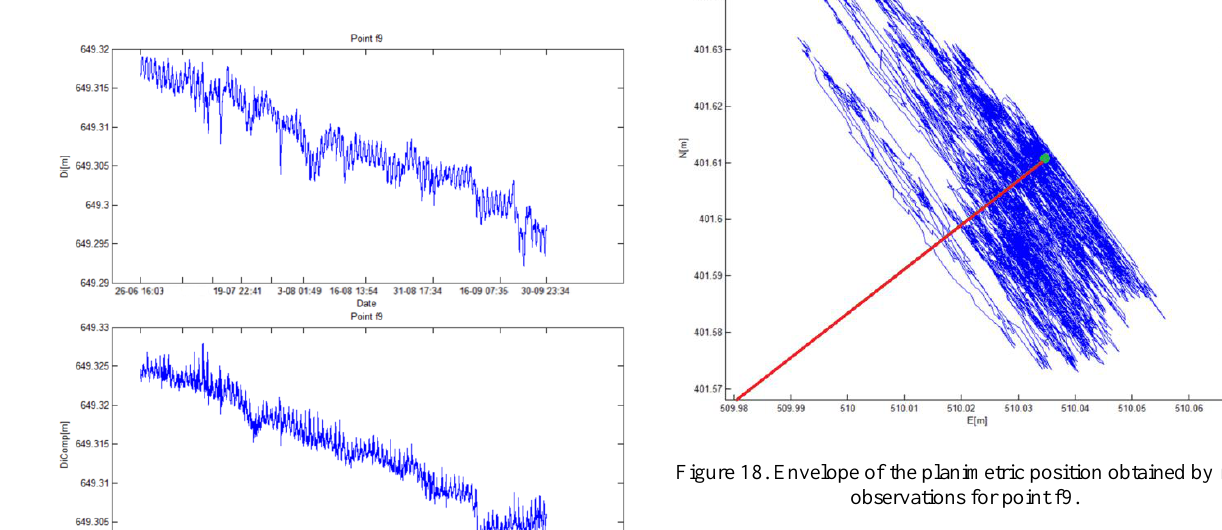
Figure 15. Envelope of the planimetric position obtained by corrected observations for point e2